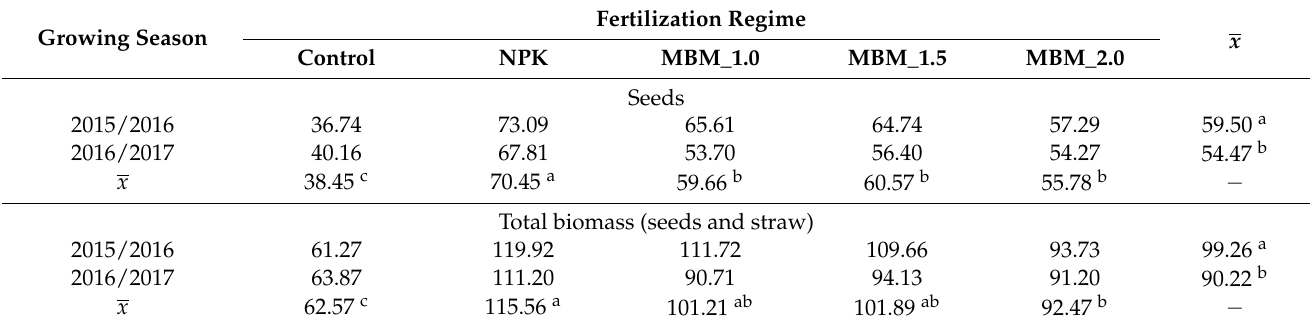
Table 9. Energy output of winter oilseed rape biomass (GJ ha − 1 ).